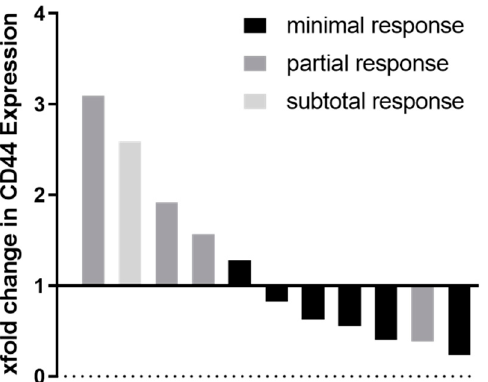
Figure 6. Fold change in CD44 mRNA levels in individual patients after neoadjuvant chemotherapy relative to baseline before treatment, grouped by histo-pathological response grading according to